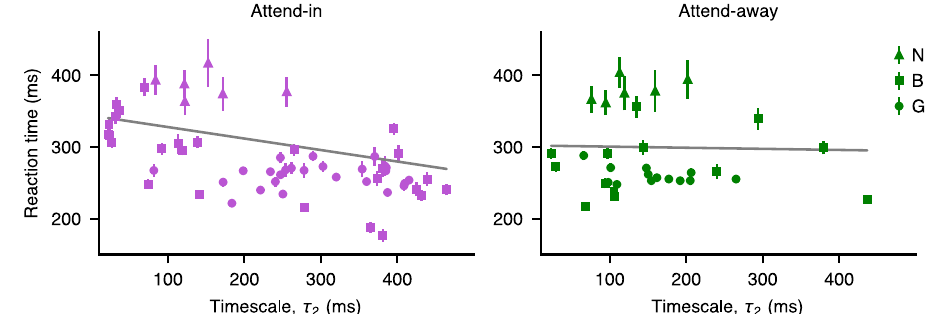
Fig. 4 | Slow timescales are correlated with monkeys ’ reaction times. Average reaction times of monkeys for each session were negatively correlated with the MAP estimates of slow timescales ( τ 2 ) in attend-in condition (left, slope= − 0.16±0.066, mean±95% CIs, p =9×10 − 6 , one-sided F-test, N =58, R 2 =0.62) but not attend-away condition (right, slope=0.015±0.12, p =0.79, one-sided F -test, N =32, R 2 =0.69). Each point represents one recording session; symbols indicate